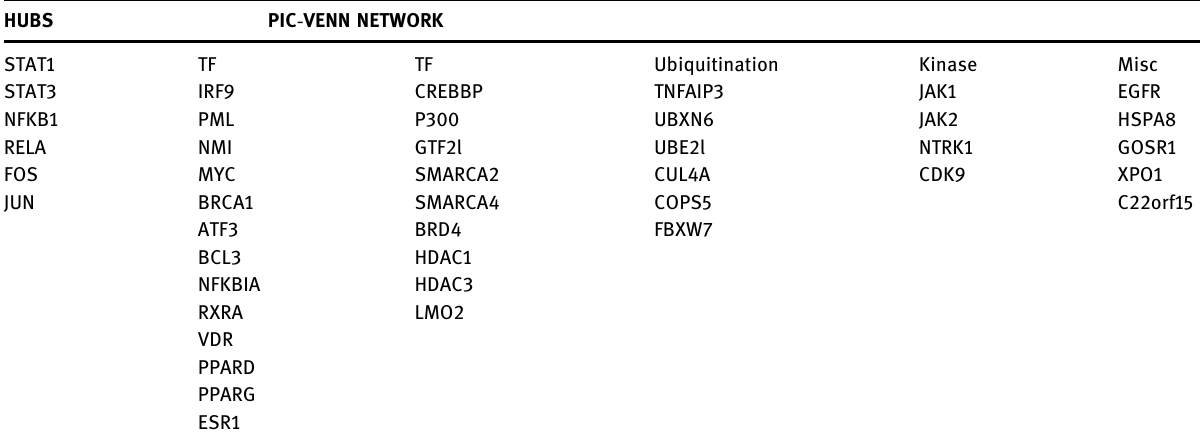
Table 4: Pairwise comparison of STAT1 with other critical hubs and PIC - Venn network in innate and adaptive immunity HUBS